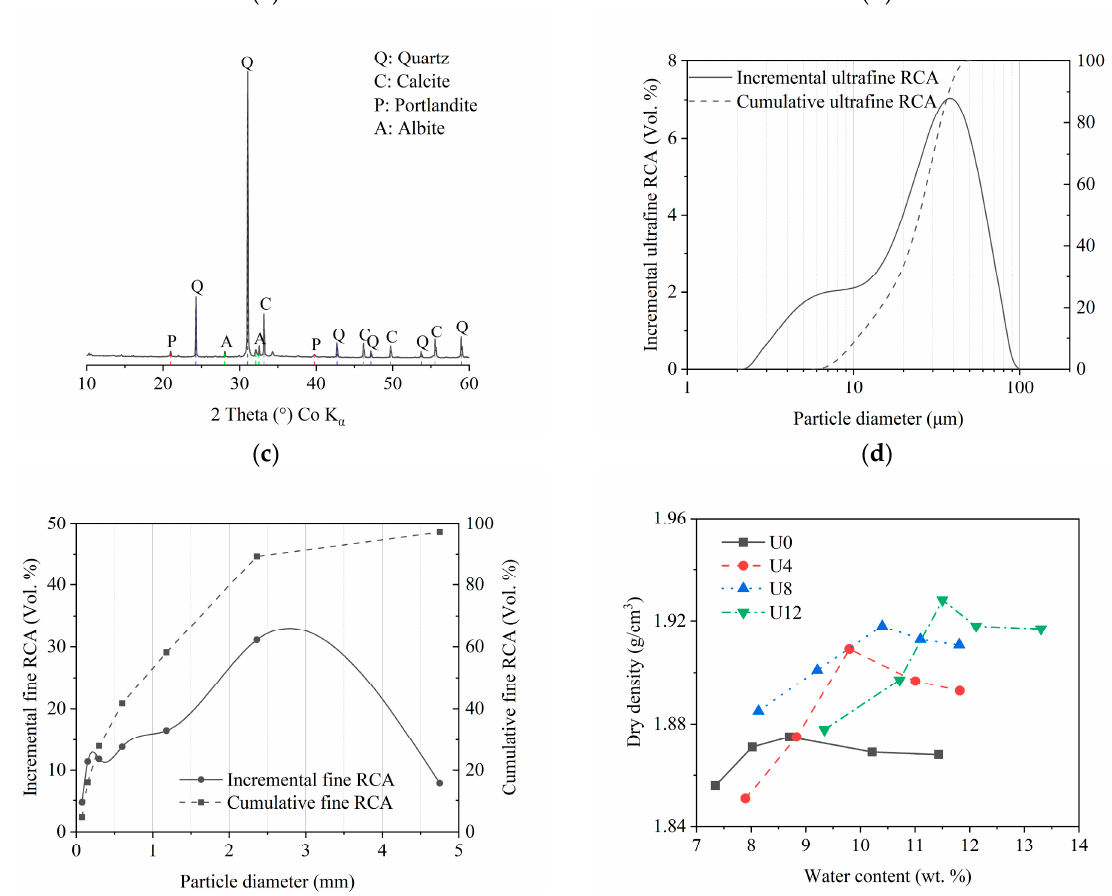
Figure 3. ( a ) XRD pattern of ultrafine RCA; ( b ) PSD of ultrafine RCA; ( c ) PSD of fine RCA; ( d ) Optimum water content and maximum drying density. Table 3. Chemical composition (wt. %) of ultrafine RCA. Table 4. Water absorption, bulk density, porosity, and crushing test of fine